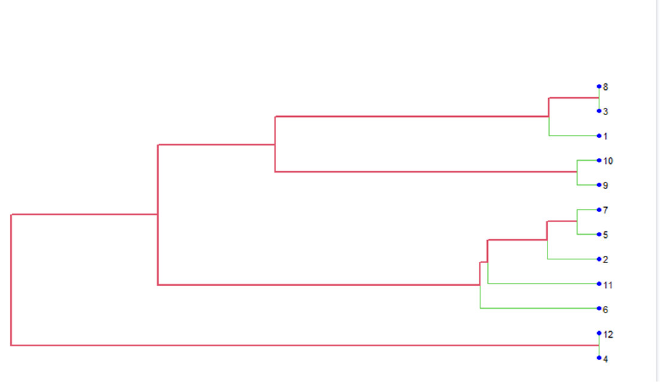
Figure 6. Dendrogram (“complete” method).* - hclust command options.